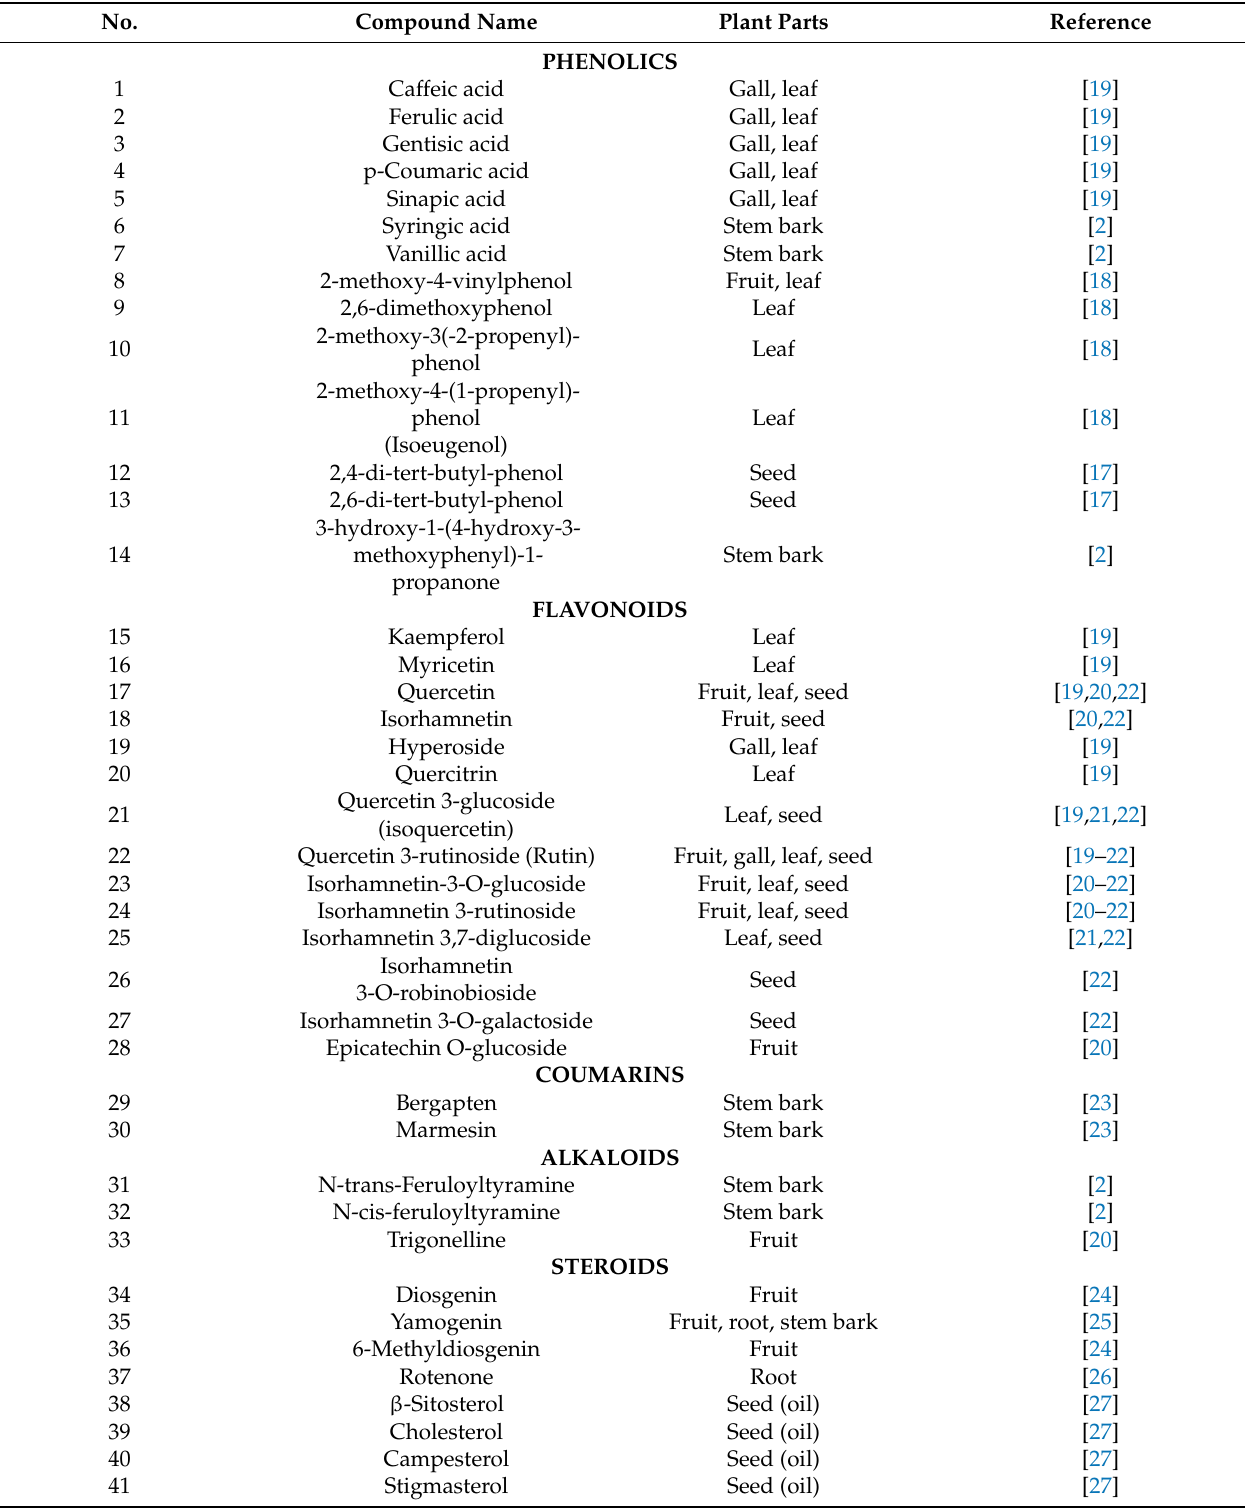
Table 5. Phytochemicals isolated from various parts of desert